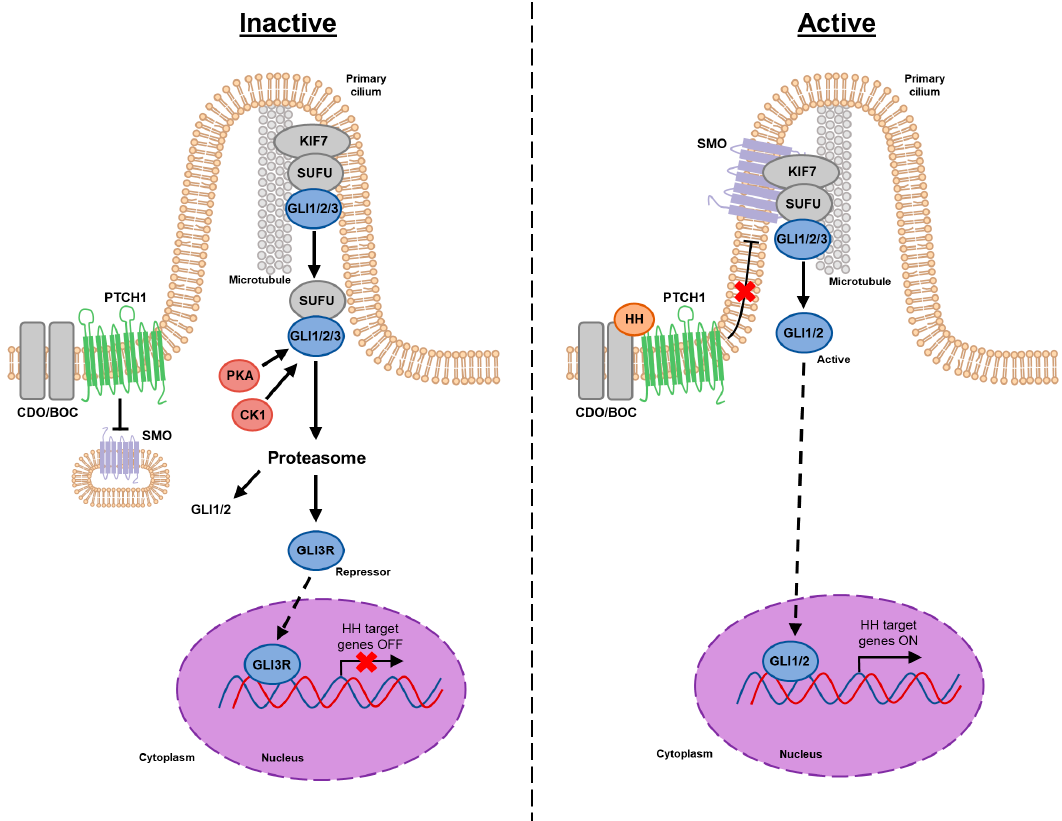
Figure 1. Overview of the hedgehog signaling pathway. Inactive signaling ( left ) occurs in the absence of HH ligand in which PTCH1 precludes SMO localization to the primary cilium, leading to GLI1 sequestration in the cytoplasm by SUFU. GLI proteins are then marked for processing, e.g., through PKA- or CK1-dependent phosphorylation, and processed into transcriptional repressors (GLI3R). Upon CDO/BOC-mediated binding of HH ligand to PTCH1 ( right ), SMO is derepressed and localizes to the primary cilium. A protein complex containing KIF7 and SUFU bound to GLI transcription factors is dynamically trafficked to the activated SMO. Active SMO promotes release of GLI proteins from SUFU, resulting in nuclear accumulation of GLI1/2 and activation of target genes.